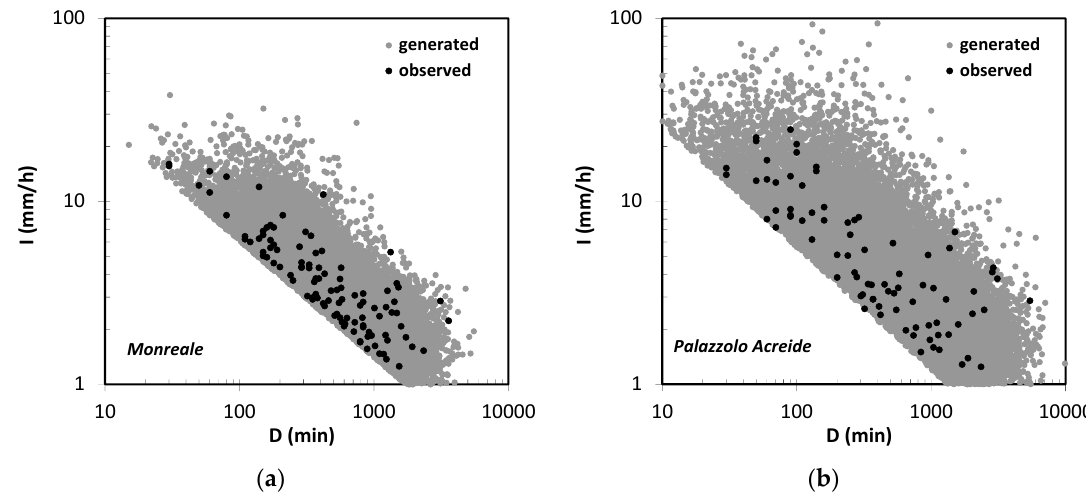
Figure 9. Comparison between 20.000 values generated from the Frank’s copulas fitted on the observed data and observed events at: ( a ) Monreale; ( b ) Palazzolo Acreide.